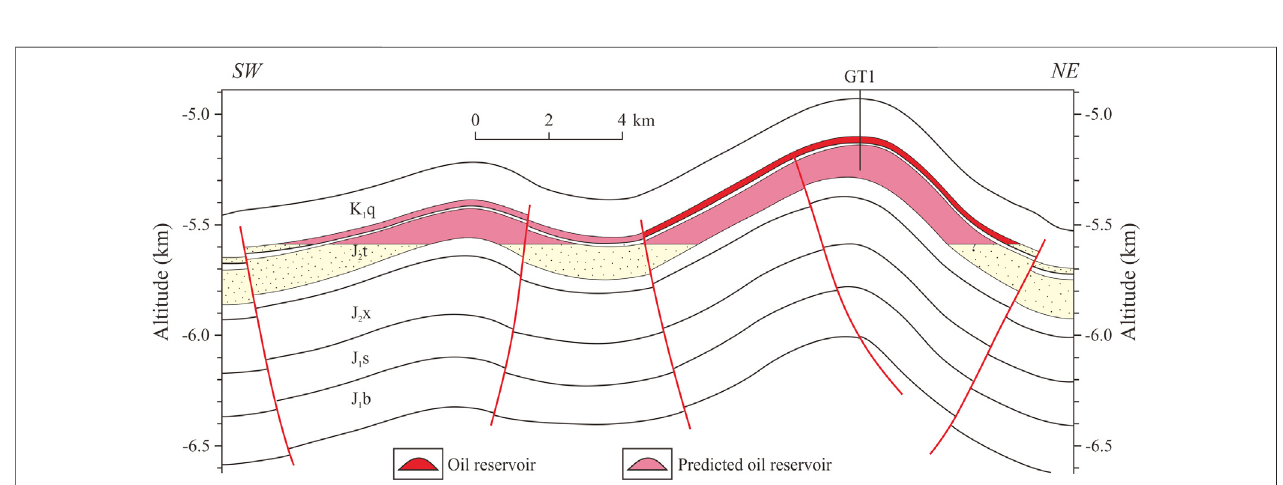
FIGURE 4 | Predicted reservoir pro fi le (through Well GT1) of Gaoquan anticline in west of southern margin (Its location is indicaten in Figure 3 ).